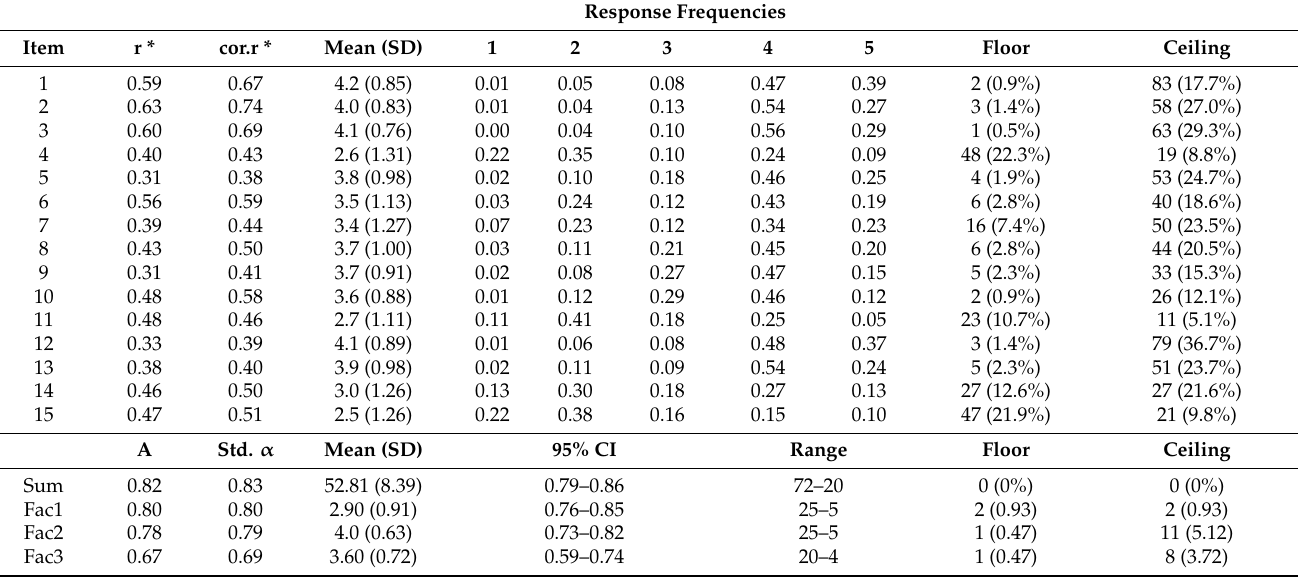
Table 2. Properties of the ASAS-R items ( n =